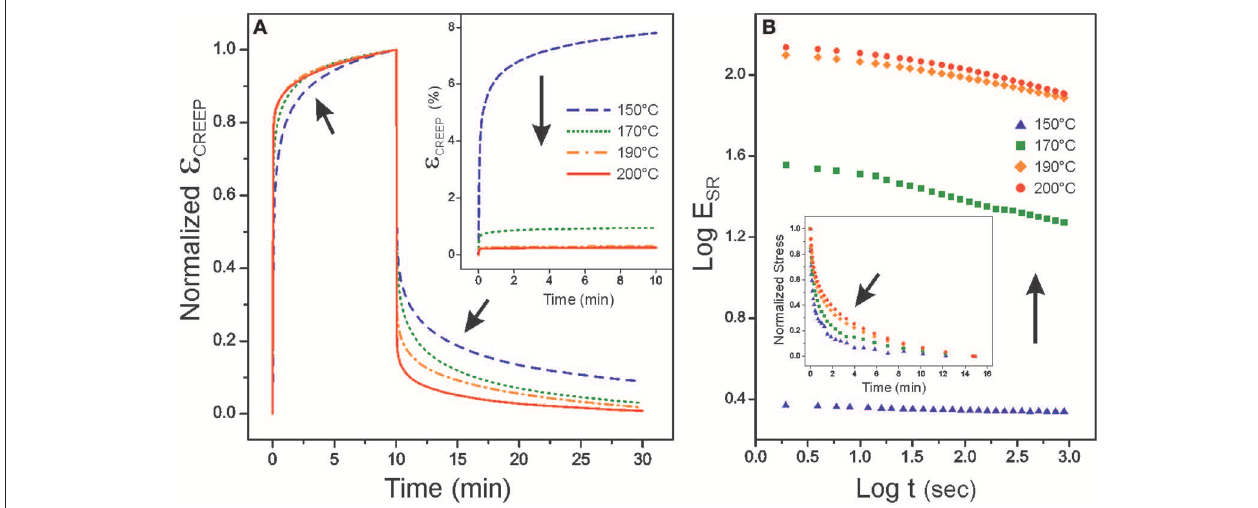
FIGURE 6 | (A) creep-recovery ( σ = 0.2 MPa) and (B) strain relaxation ( ε = 0.5%) curves of polyaleuritate films prepared in the 150–200 ◦ C range for 22h in air. Arrows are included to highlight results indicating a structural